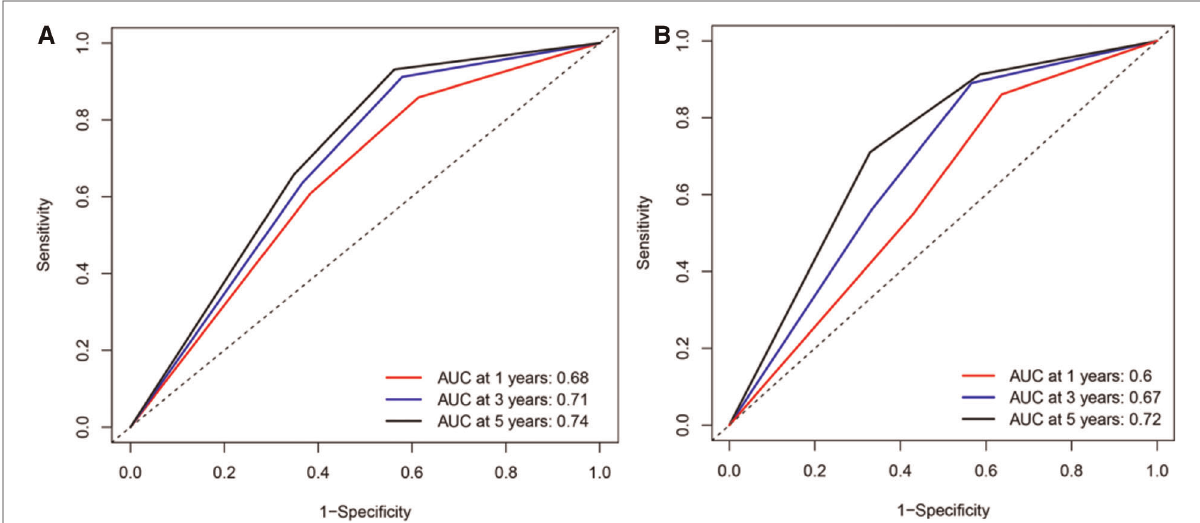
FIGURE 3 Receiver operating characteristic (ROC) curve for overall survival (OS) of patients undergoing enhanced recovery after surgery combined with robotic radical gastrectomy based on the nomogram. ( A ) ROC curve for 1-/3-/5- year OS based on the nomogram in the training set. ( B ) ROC curve for 1-/ 3-/5- year OS based on the nomogram in the validation set. AUC, area under the curve.